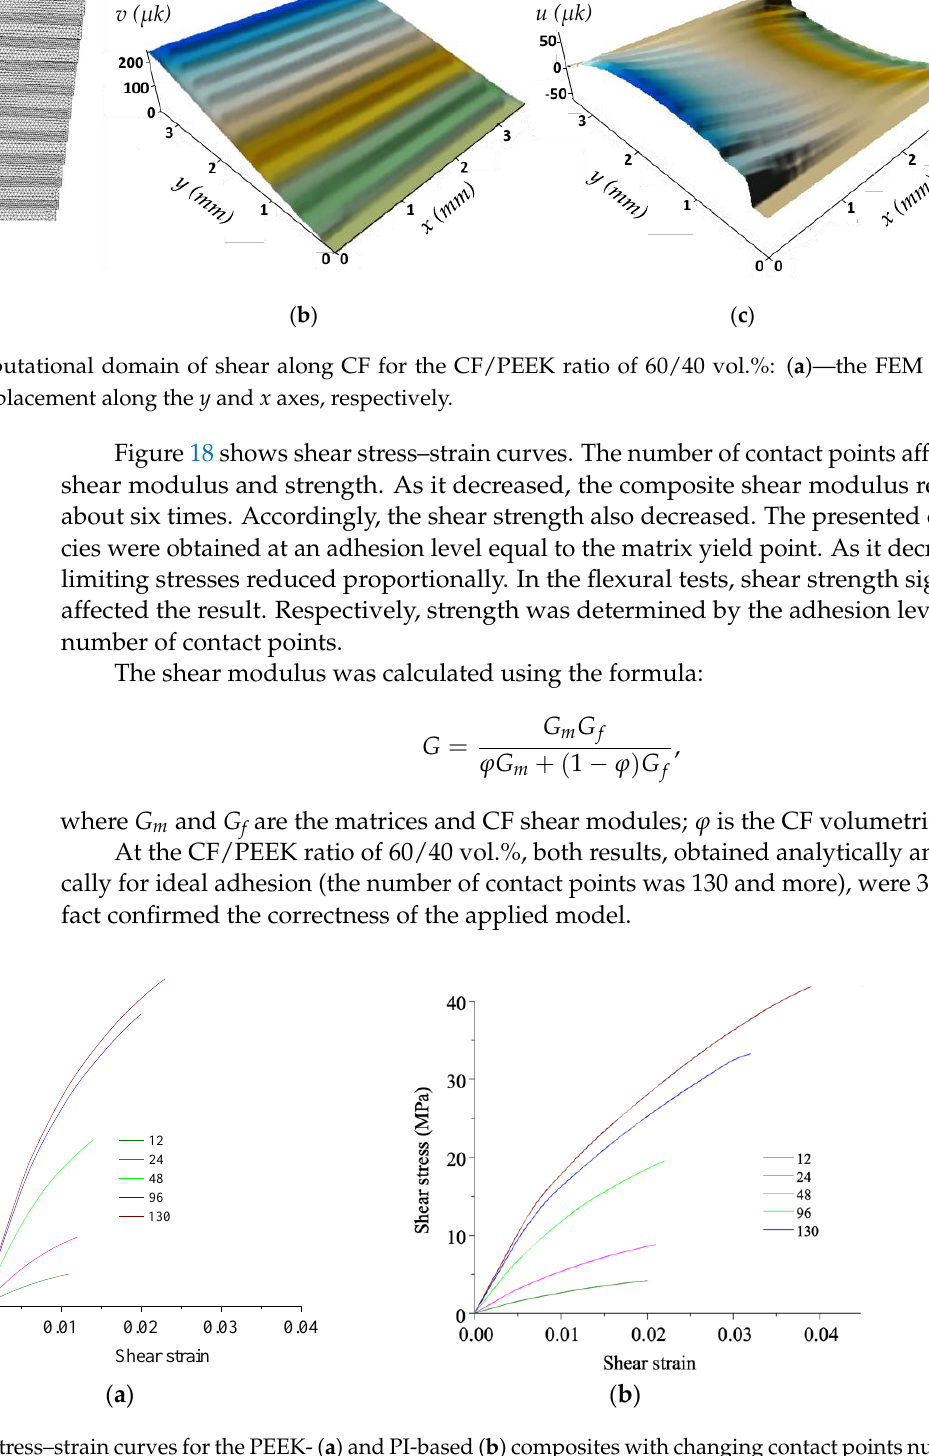
( b ) Figure 16. Stress vs. strain intensities of the PEEK- and PI-based composites under tension along the y -axis (across CF) with changing in the number of contacting points between the polymer and CF: the CF/polymer ratios of 80/20 ( a ) and 60/40 vol. % ( b ).